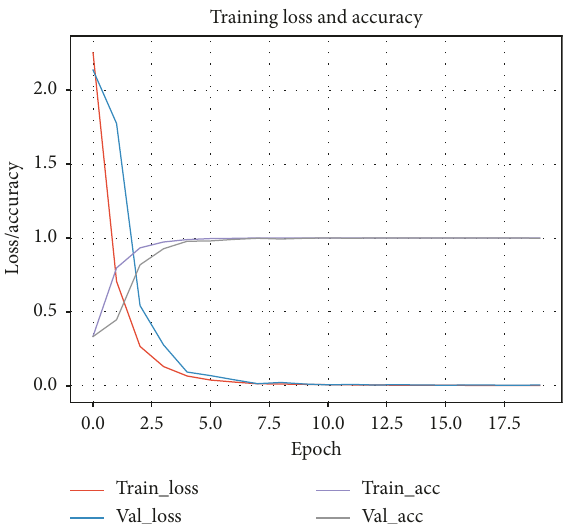
Figure 16: Accuracy and loss during inception V3 training and validation.